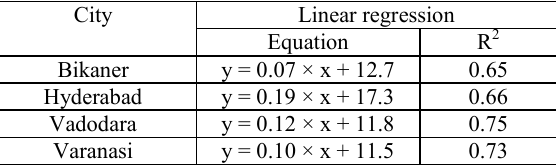
Table 4. The equation and coefficient of determination (R 2 ) for the linear regression for night LST with % Impervious.